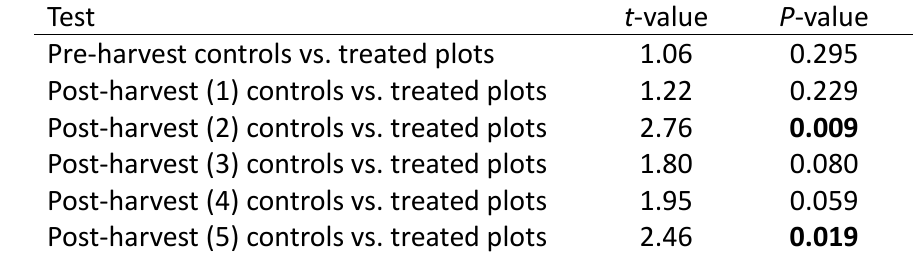
Table A1 . 1 . Year-specific treatment effects on density of Black-throated Green Warbler, according to multiple comparison analyses (DF = 40).